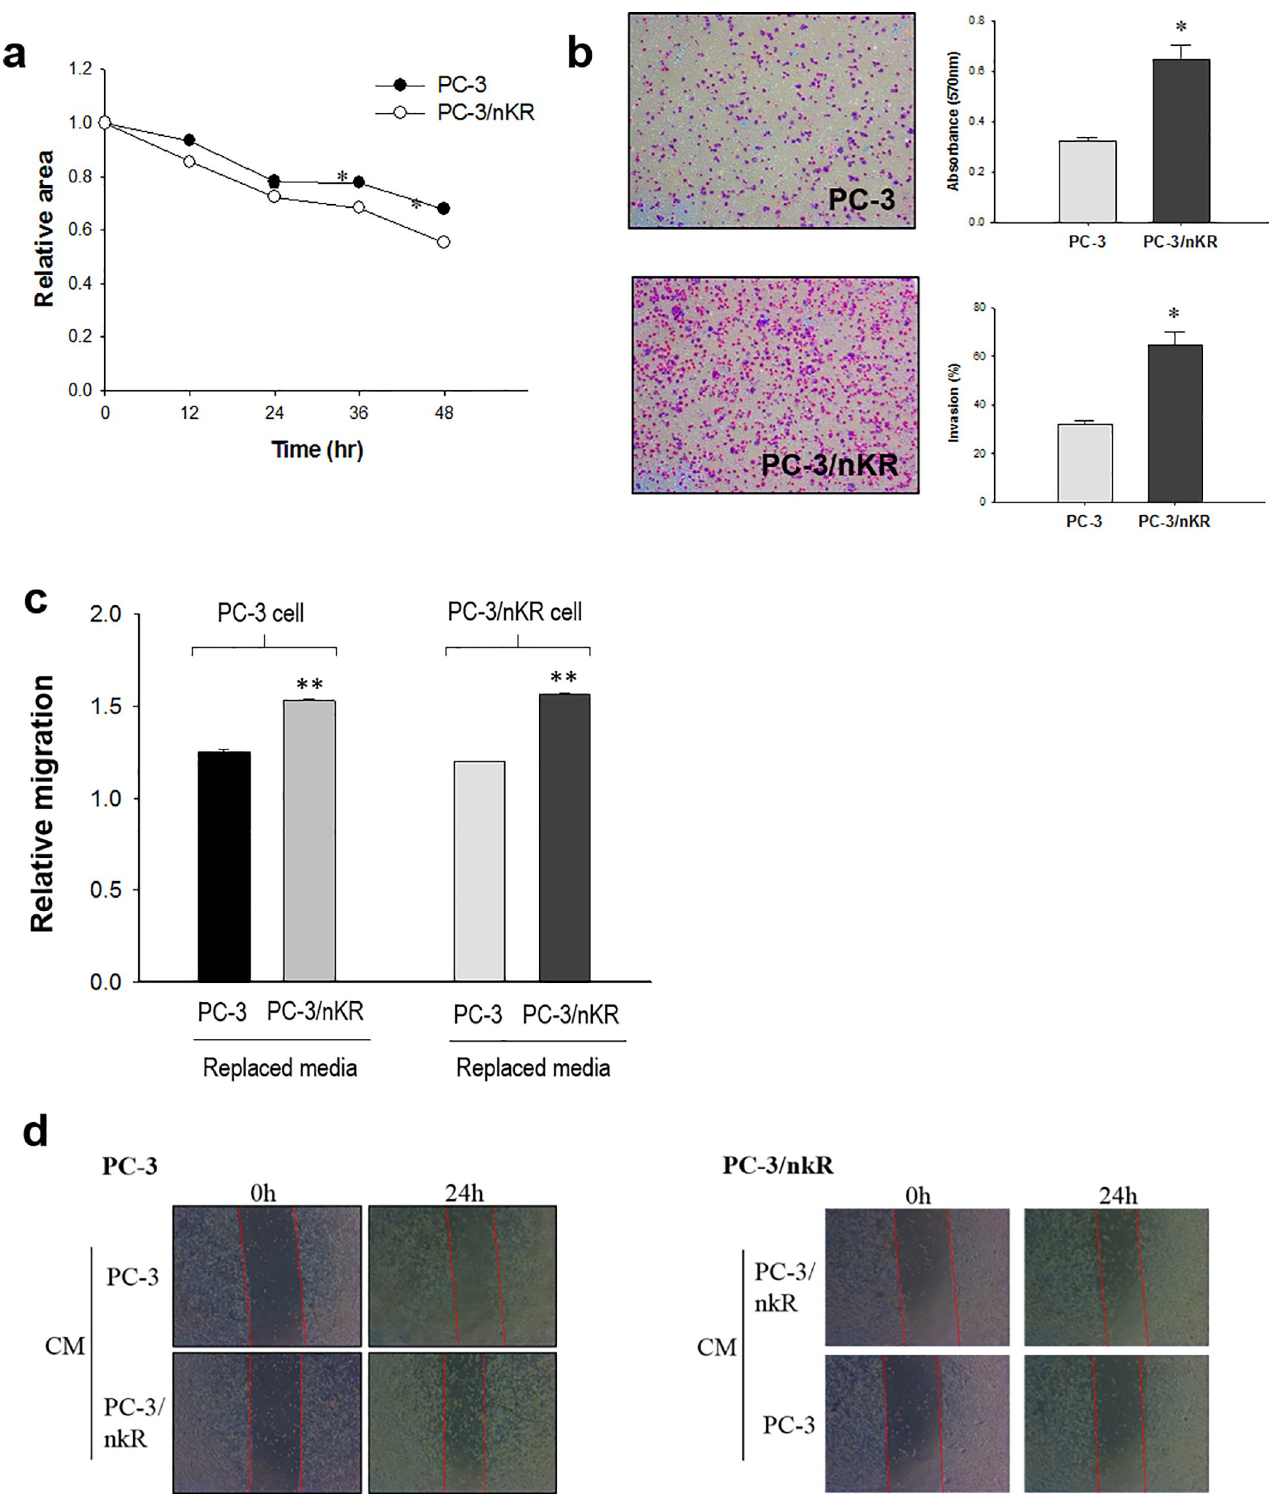
Fig 1. The characteristics of PC3 and PC3/nKR cells. (A) The relative wound area in wound scratch assays PC-3 and PC-3/nKR cells scratched by a tip were observed under light microscopy at intervals of 12 h and the results were normalized to those for PC-3 cells. (B) Representative images of cells that had invaded into a Transwell chamber are shown. (C) Effects of incubating PC-3/PC-3/nKR cells with the conditioned media (CM) from PC-3/nKR cells for 48 h, respectively. All the experiments were conducted in triplicate ( �� P < 0.01, ��� P < 0.001). Relative migration is defined as the reciprocal of the relative distance